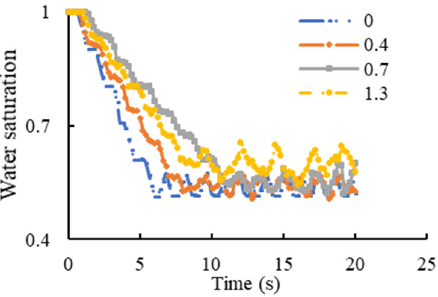
Figure 8. Variation of average water saturation with time for single-fracture models.